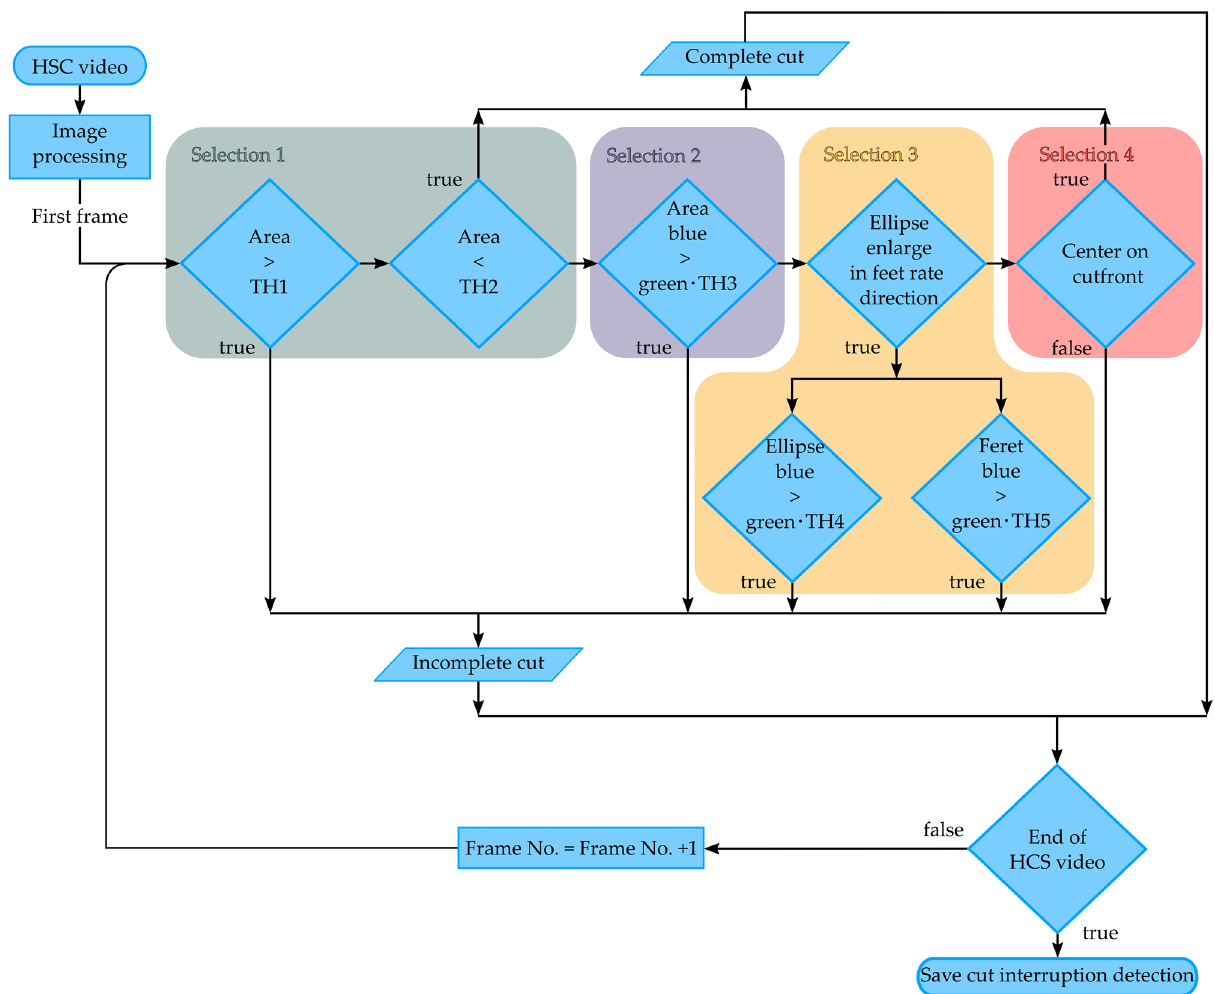
Figure 11 . Flowchart of the algorithm to detect incomplete cuts. Figure 11. Flowchart of the algorithm to detect incomplete